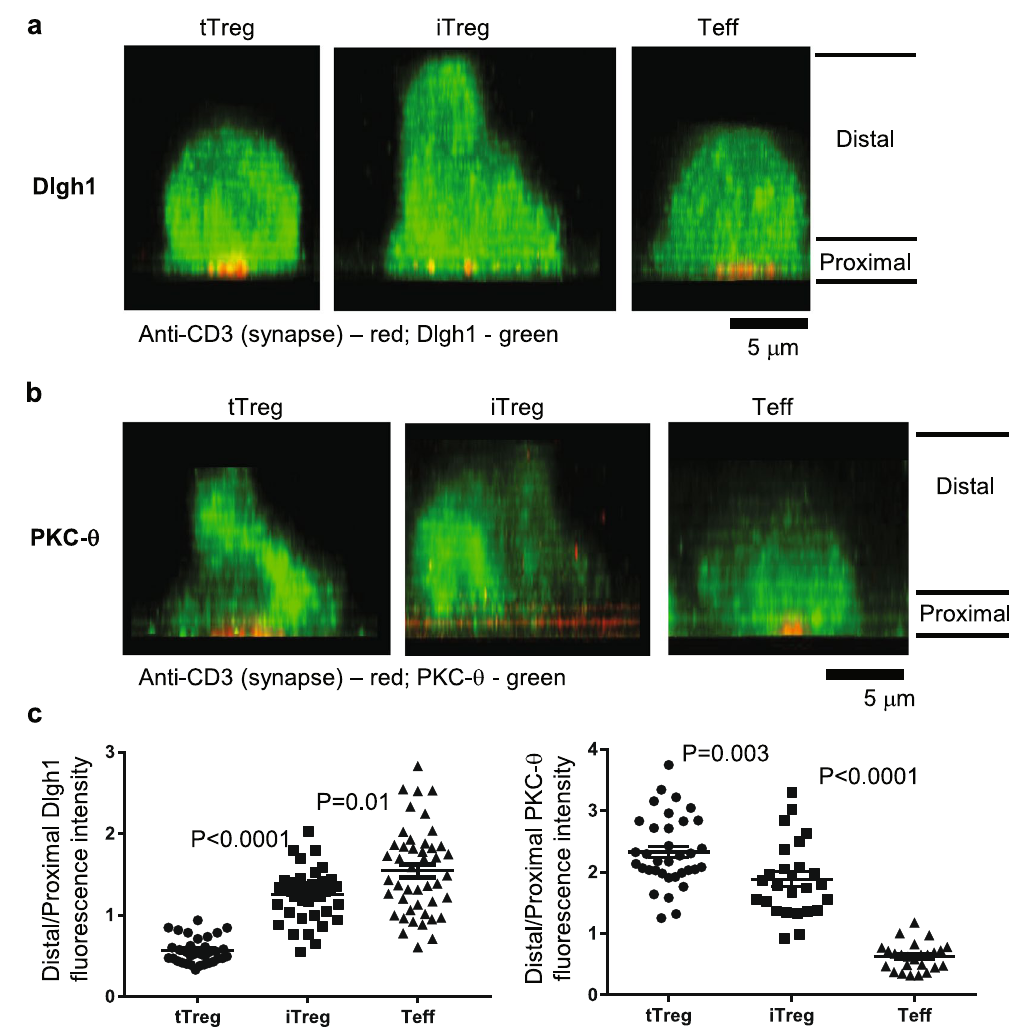
Figure 2. Side view of Dlgh1 and PKC- θ intracellular distribution in tTreg, iTreg and Teffs. The cells were activated using lipid bilayers as mentioned above, for 10 min at 37 °C, fixed and processed for Dlgh1 and PKC- θ immunofluorescence. Cells were imaged using line scanning confocal microscope, and images were 3D projected to reveal intracellular distribution of aforementioned proteins. Anti-CD3 (pseudocolored red) marks synaptic and proximal areas, while the proteins have been pseudocolored green. Note the enriched distribution of Dlgh1 at the proximal and of PKC- θ towards distal side in tTreg (left panels), and a reduction of this distribution in iTreg (middle panels). The panels show representative images. Dlgh1 and PKC- θ staining was quantified by calculation of average fluorescence intensity in cells. Data are representative of two different experiments. P values were calculated using Mann-Whitney